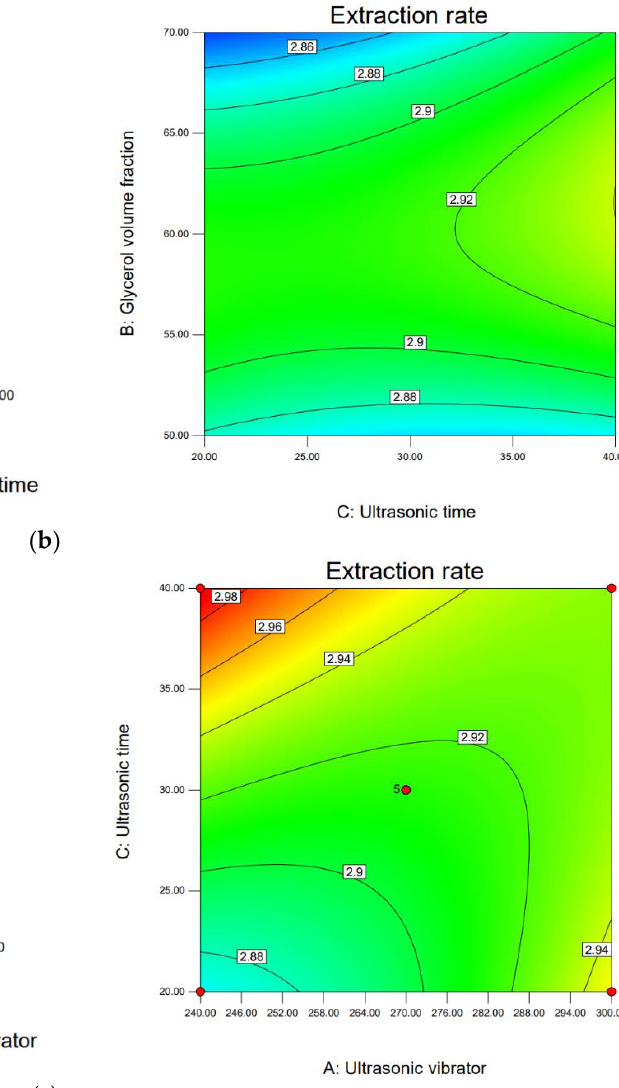
Table 6. Validation fitting results under optimal process conditions.